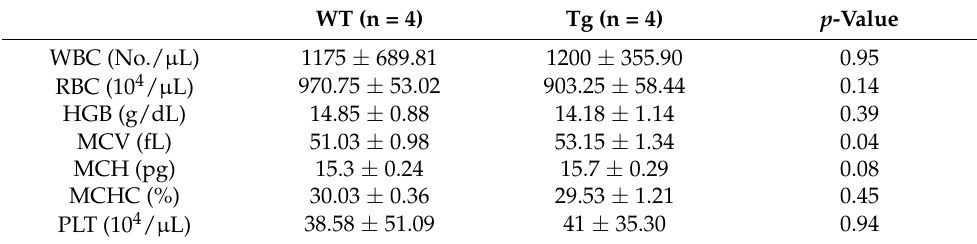
Table 1. Hematology analysis (8-week-old female